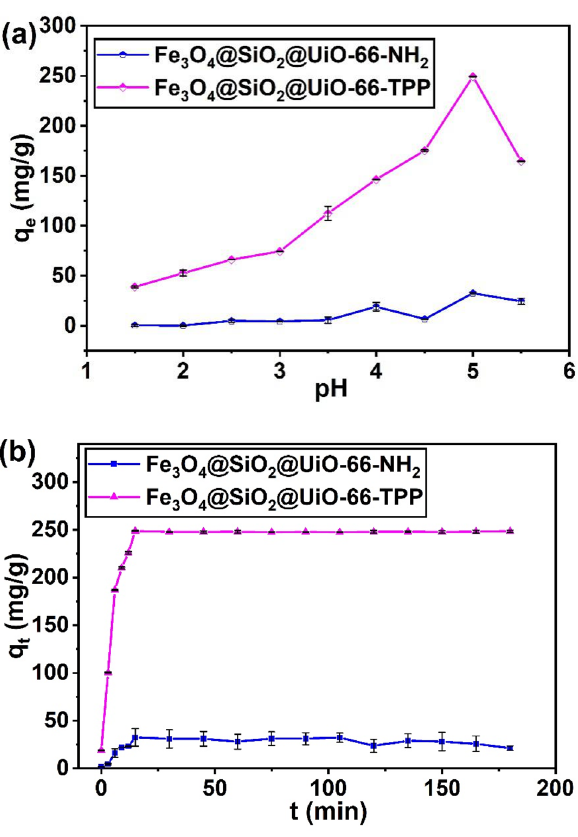
Figure 5. Effects of initial solution pH and contact time (pH 5.0 ± 0.1) on adsorption of U(VI) by Fe 3 O 4 @SiO 2 @